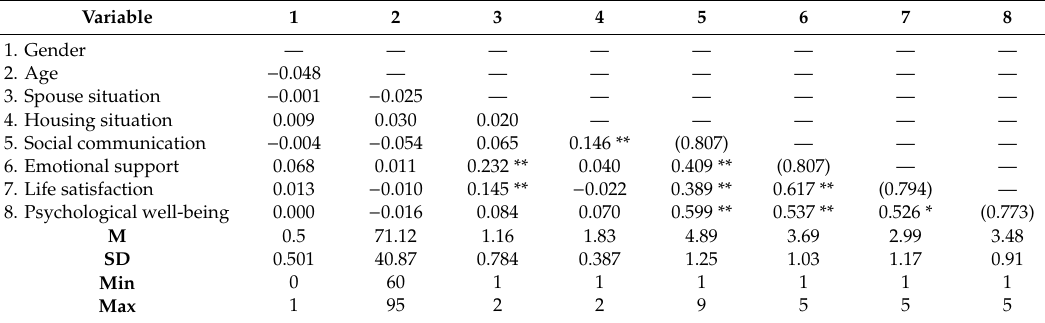
Table 1. Descriptive statistics and correlations for all measures (N = 658).